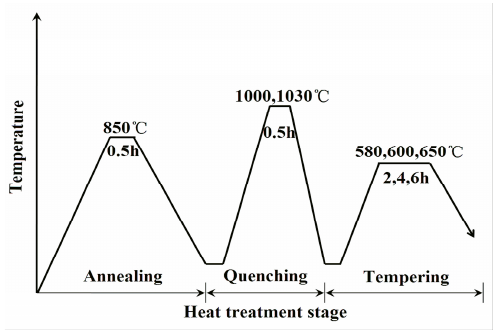
Figure 1. Heat-treatment regime of samples.